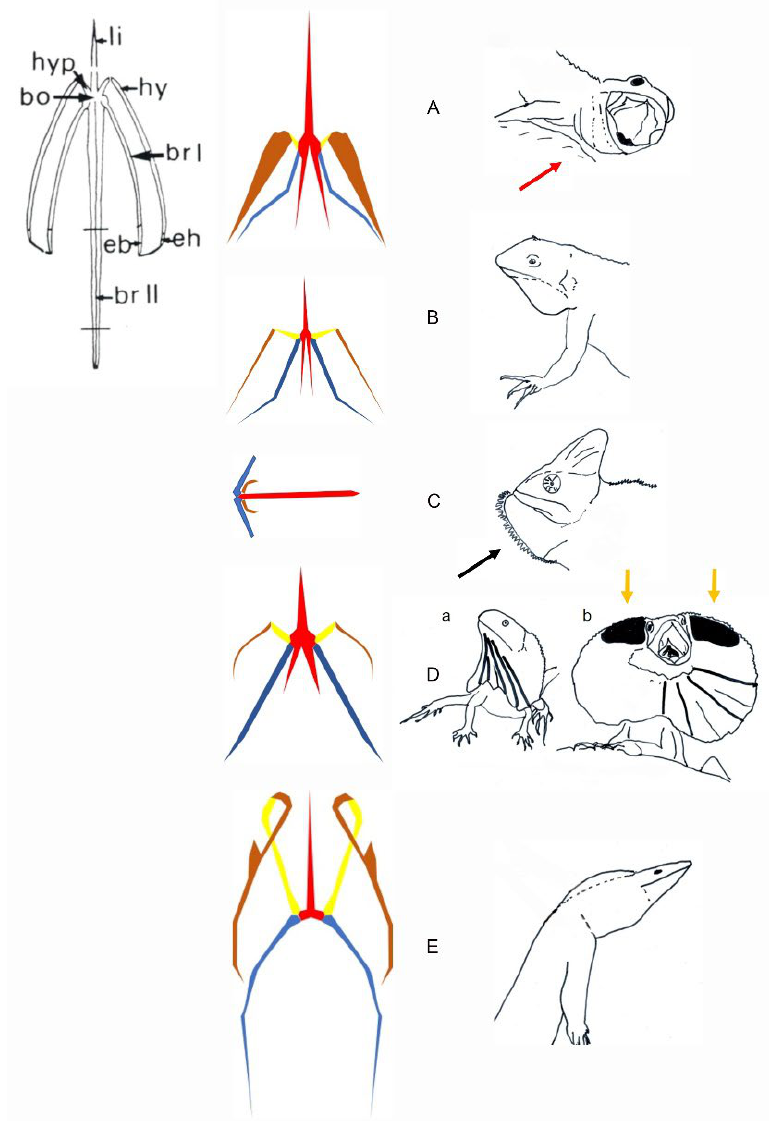
Figure 15. Schematic representations of the hyoid apparatus in relation to the recorded throat extension in lizards. Anatomical description of all elements of a hyoid apparatus ( Anolis carolinensis ) is provided in the upper left corner. The hyoid anatomy and display behaviors are illustrated for various lizards. ( A ) The hyoid apparatus of Lacertoidea. The display in Lacertoidea involves a very small throat extension often associated with gaping (red arrow). ( B ) Representative hyoid apparatus in Toxicofera, Pleurodonta ( Sceloporus sp.) and Acrodonta. The display of most of the species shows a limited throat extension. ( C ) Representative hyoid apparatus in Acrodonta Chameleo sp. The display (illustrated in Brokesiinae) remains to be investigated functionally. The black arrow shows the potential effect of additional lingual movement on the shape of the signal. ( D ) Representative hyoid apparatus in Chlamydosaurus kingi . This lizard uses frill erection. a. Resting posture. b. Full frill erection. Yellow arrows indicate Grey’s cartilage (black areas) helping support dorsally the fully erected frill. ( E ) Representative hyoid in Varanus sp. (Toxicofera, Anguimorpha). The display in Varanus sp. Involves various throat extension (see Figure 16D). bo, hyoid body, br I, ceratobranchial I; br II, ceratobranchial II; eb, epibranchial; eh, epihyal; hy, ceratohyal; hyp, hypohyal; li, lingual or entoglossal process. The hyoid elements are colored following their relative movements. Red, the hyoid body, entoglossal process and ceratobranchials II in solidarity movements; yellow, hypohyal; brown, ceratohyal; blue, ceratobranchial I.